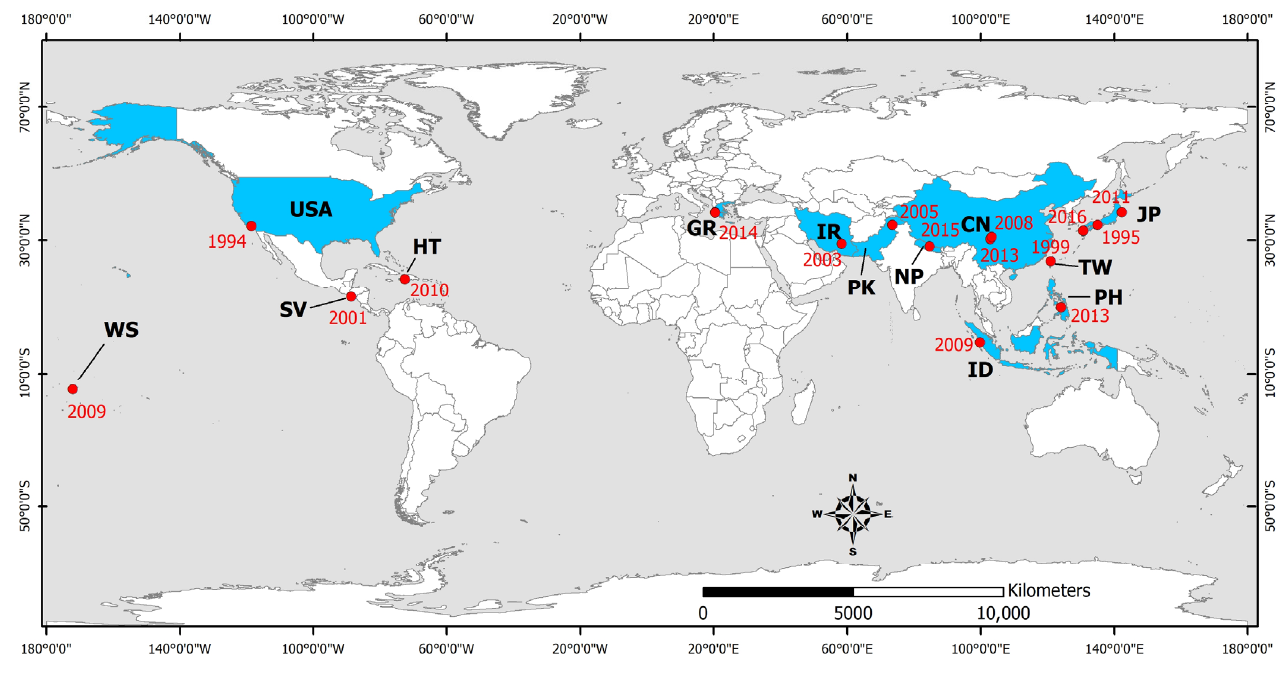
Figure 2. Distribution of countries affected by earthquakes that triggered the occurrence of respiratory